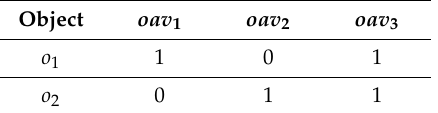
Table 3. Matrix OOA A .